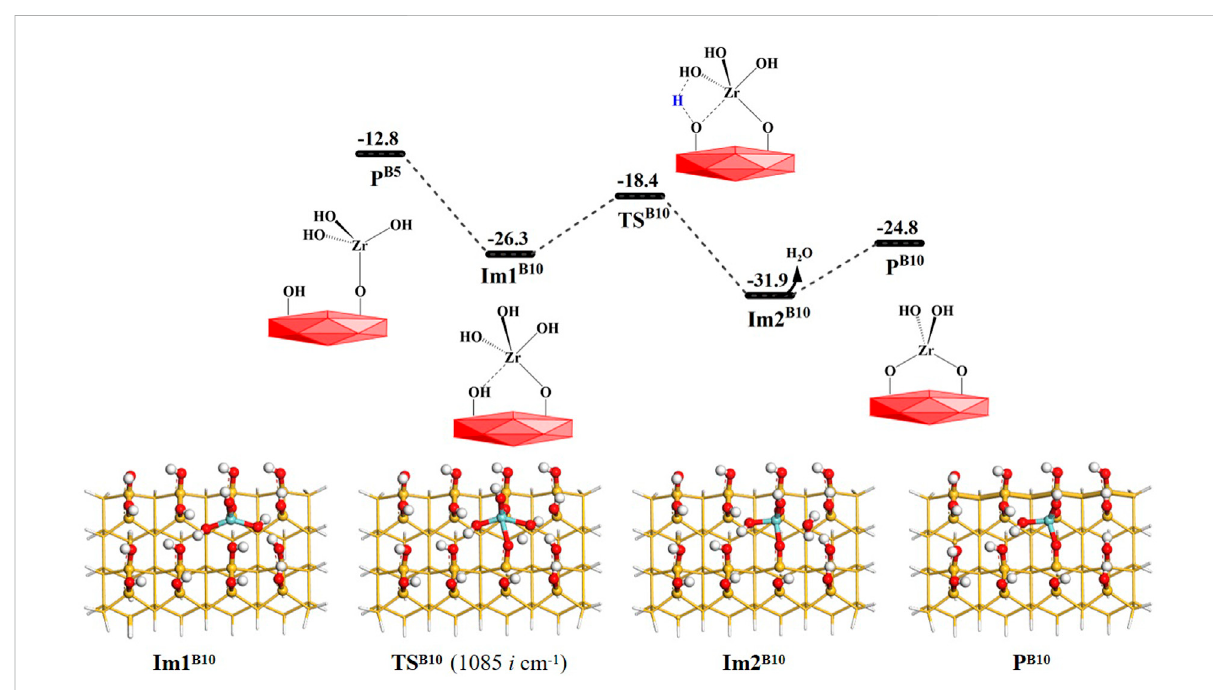
FIGURE 14 Gibbs free energy ( Δ G , kcal/mol) pro fi les of the B10 section of the H 2 O reaction with the aminated